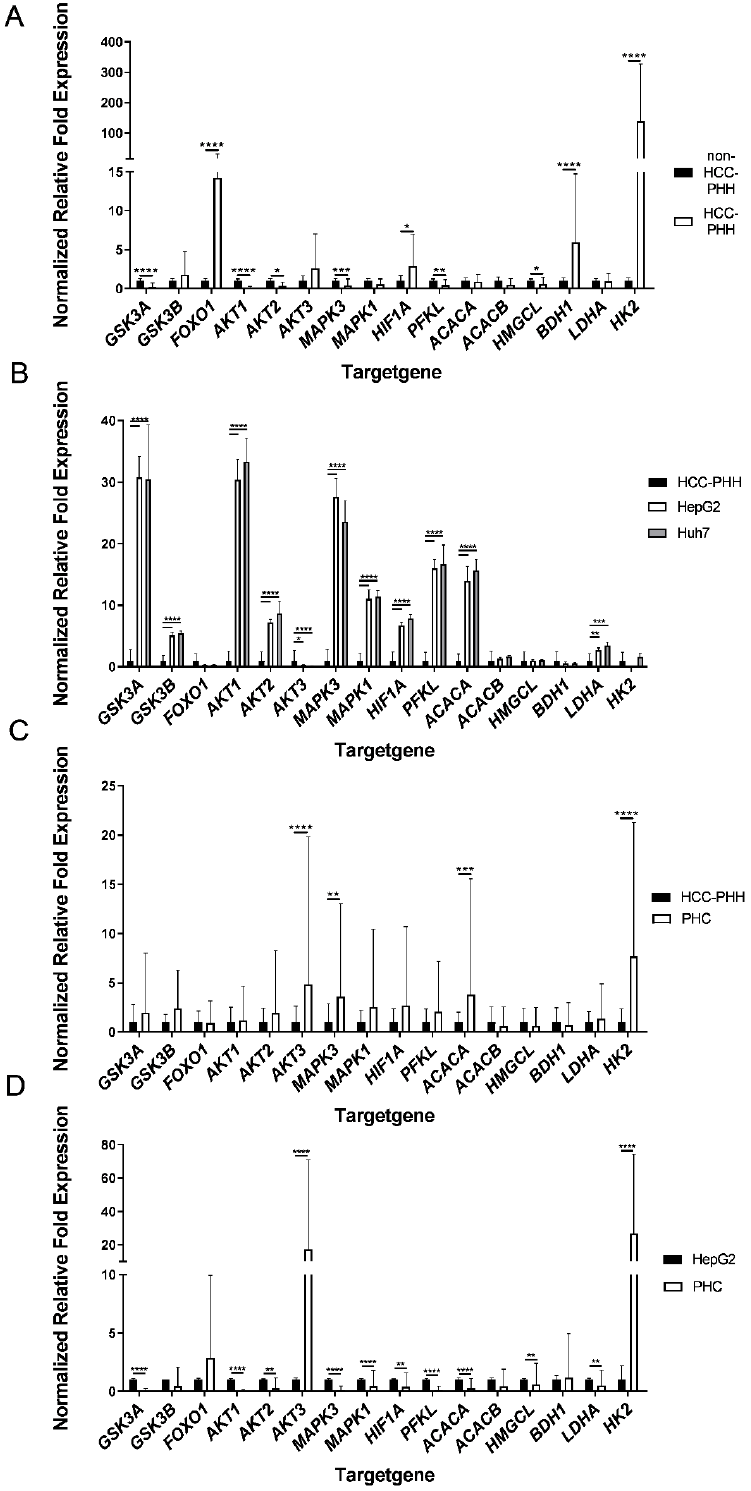
Figure 3. Differentially expressed energy metabolism genes of hepatocytes, hepatocellular carcinoma cells and hepatoma cell lines. Cells were cultured for 20 h or snap-frozen directly after isolation, and relative mRNA expression levels of central actors in hepatic energy metabolism were de- termined by RT-qPCR. ( A ) PHHs from non-HCC patients (N = 4) were compared with PHHs from HCC-diagnosed patients (N = 9) and showed distinct metabolic gene expression profiles. ( B ) Gene expression data of the hepatoma cell lines HepG2 and Huh7 (N = 3) were normalized to PHHs from HCC donors (N = 9). ( C ) PHCs (N = 6) showed different gene expression patterns to PHHs and ( D )